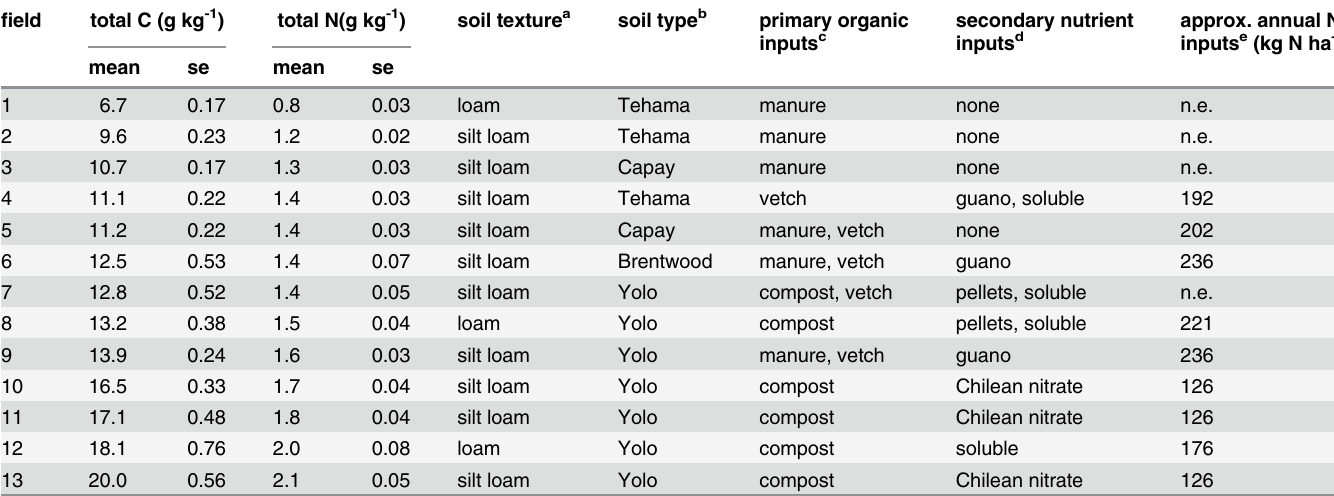
Table 1. Soil characteristics, soil types, and nutrient management of the 13 organic tomato fields studied in Yolo County, California, USA. fi eld total C (g kg -1 )